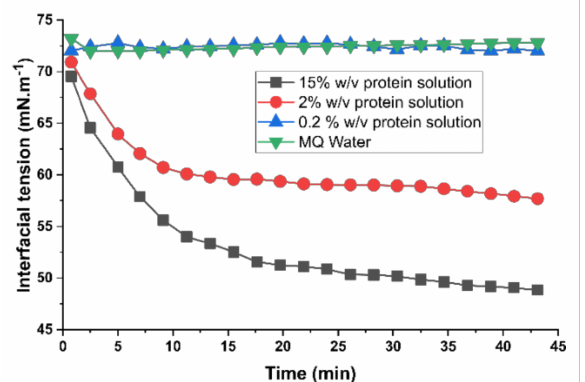
Figure 5. Changes in the interfacial tension of silk solution during drying over time.